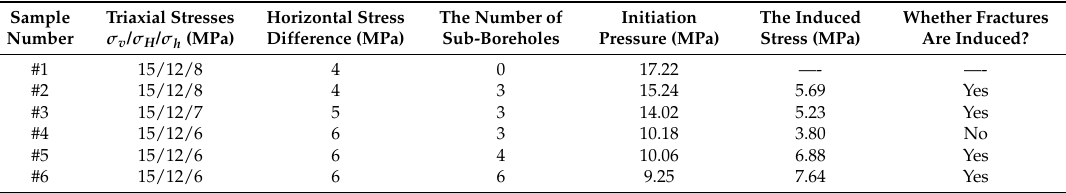
Table 1. Experimental conditions for tree-type triaxial fracturing